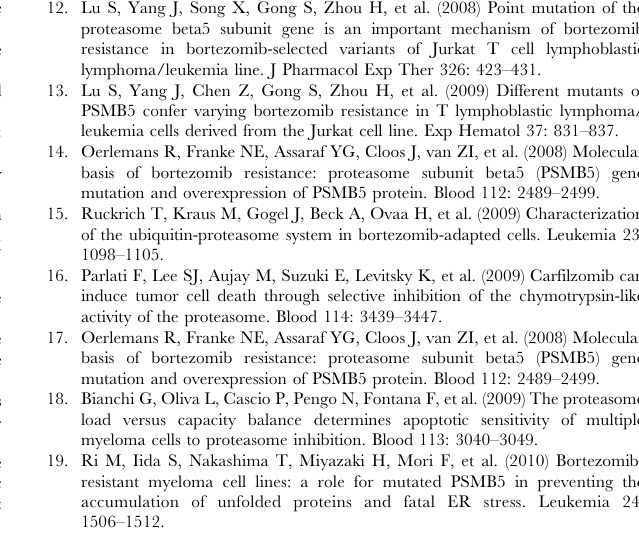
Figure S5 Serine Protease off-target activity in bortezo- mib-resistant cells. BR100 and BR200 cells were cultured without bortezomib for 3 or 14 days, along with parental cells, and cells were harvested for immunoblot analysis. Either cell lysates from PBMCs or SH-SY5Y cells were used as appropriate controls. Data are representative of 2 separate experiments. (TIF) Table S1 Genes with Two Fold or Greater Change in Gene Expression in both BR100 and BR200. (XLSX) Table S2 Fold Change of Genes Expressed in Wild-type and/or Resistant Cell Lines Related to Proteasome Function or Drug Resistance. Table S3 Genes Deleted in BR100 with a Two Fold or Greater Gene Expression Change. Table S4 Genes Deleted in BR200 with a Two Fold or Greater Gene Expression Change. Table S5 Genes Amplified in BR100 with a Two Fold or Greater Gene Expression Change. Table S6 Genes Amplified in BR200 with a Two Fold or Greater Gene Expression Change. Table S7 Summary of Tables S3, S4, S5,